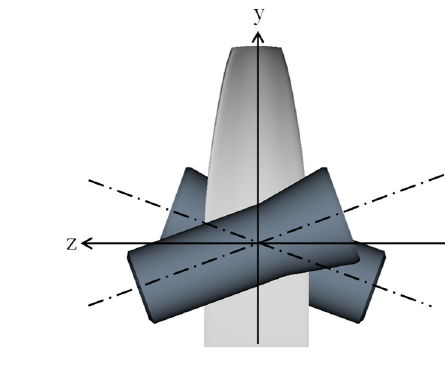
(1) Table 4. Value of the parameters in Voce law.